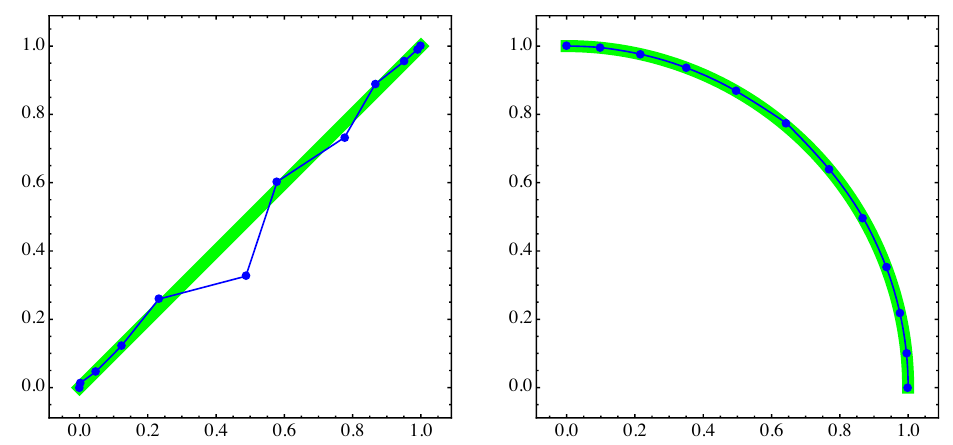
Figure 12. Left: approximations A (blue dots) corresponding to the 500th generation of the MOEA/D algorithm), and B (blue polygon line) of the Pareto set (green thick line) of MOP (12) for n = 2. Right: respective approximations F ( A ) and F ( B ) of the Pareto front for γ = 1/2.